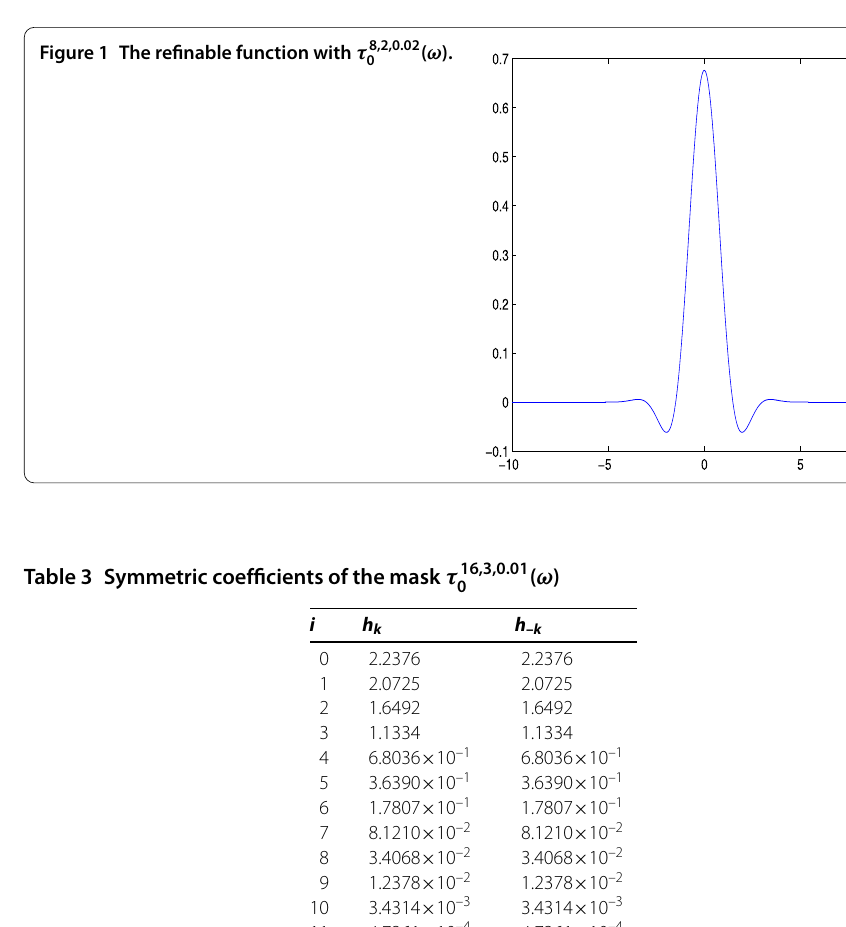
Figure 1 The refinable function with τ 8,2,0.02